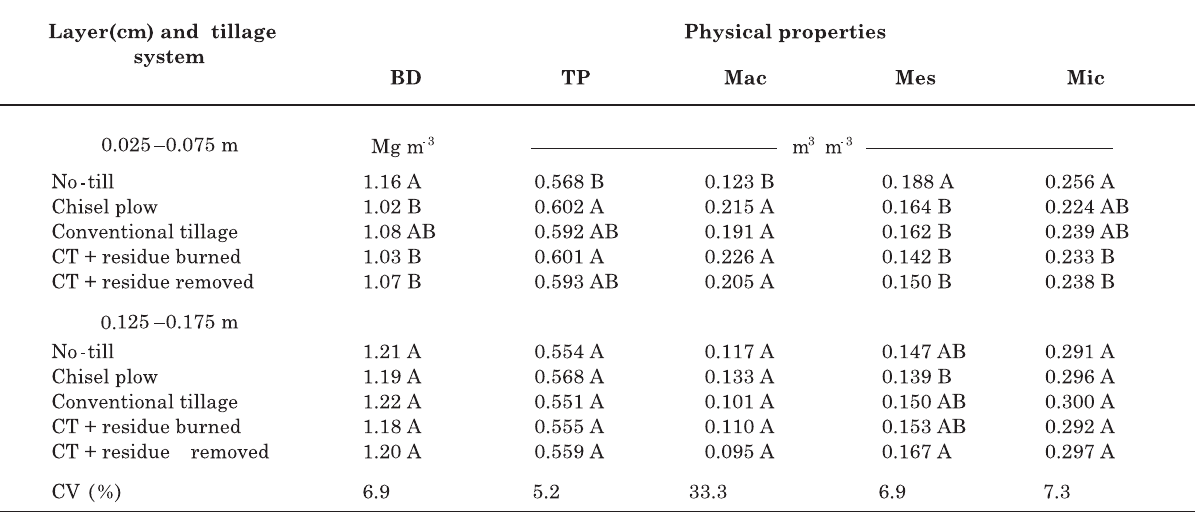
Table 3. Physical and hydraulic properties determined in two layers of five tillage systems (averaged across sampling dates in the tenth